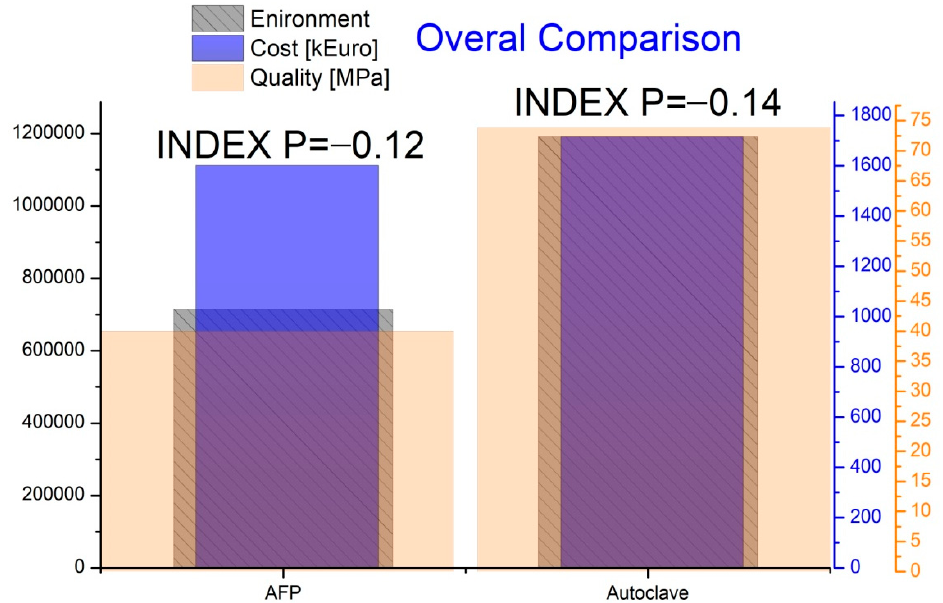
Figure 10. Comparison of the Quality, Cost and the Environmental footprint terms of the Index P for the AFP and Autoclave processes.